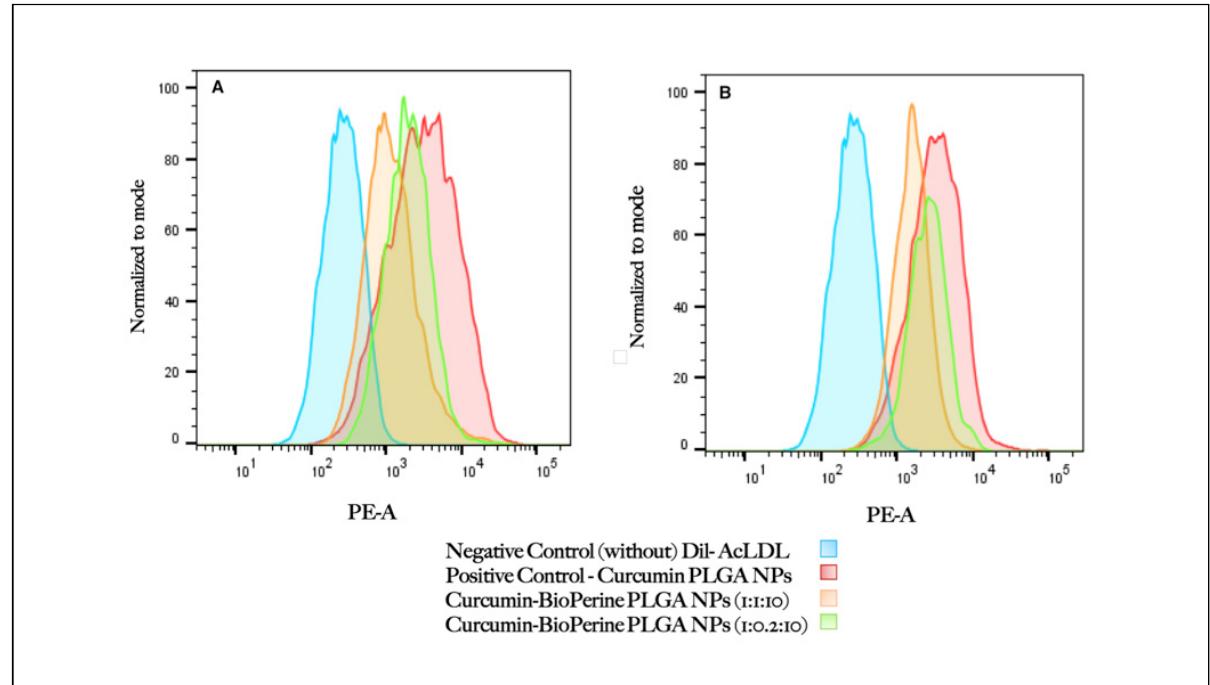
Figure 9. Cellular uptake of Dil-AcLDL by THP-1 monocyte-derived macrophage cells treated with curcumin-Bioperine PLGA NPs (1:1:10 and 1:0.2:10) and Cur-PLGA NPs for ( A ) 24 h, ( B ) 48 h followed by incubation with Dil-AcLDL for 4 h and flow cytometry analysis.